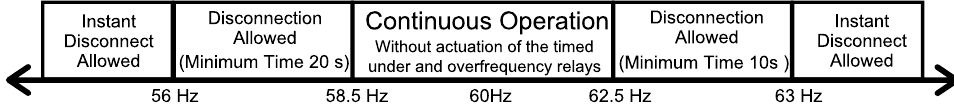
Figure A2. Nonrated frequency regime for hydropower units [38]. Figure A3. Supportability curve for transient undervoltage and overvoltage LVRT [38]. Table A10. System frequency limits in case of perturbation. Frequency Range (Hz)